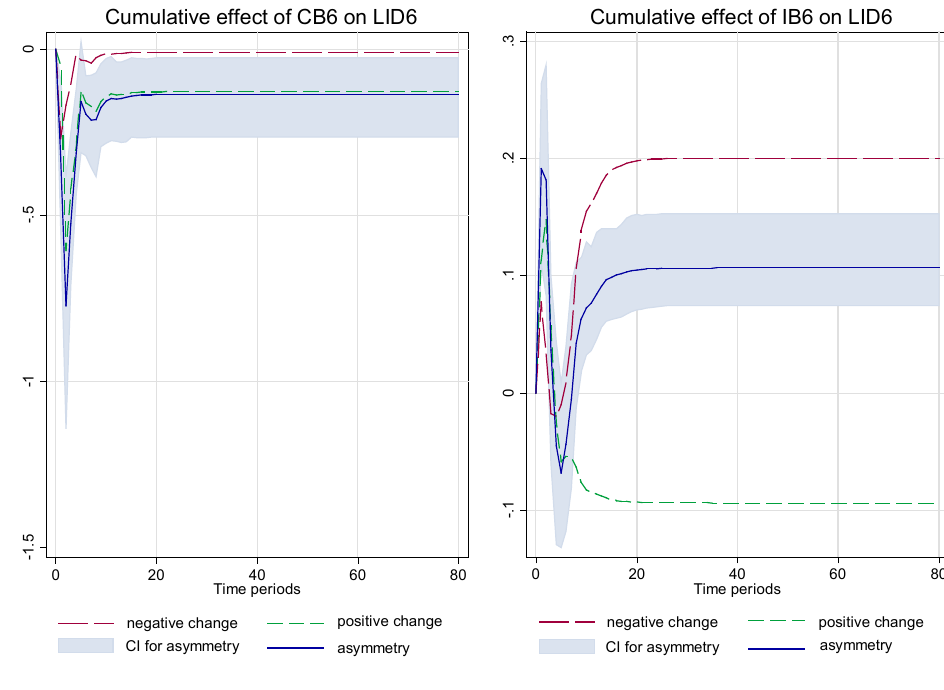
Figure 3. Dynamic multipliers, 6-month maturity